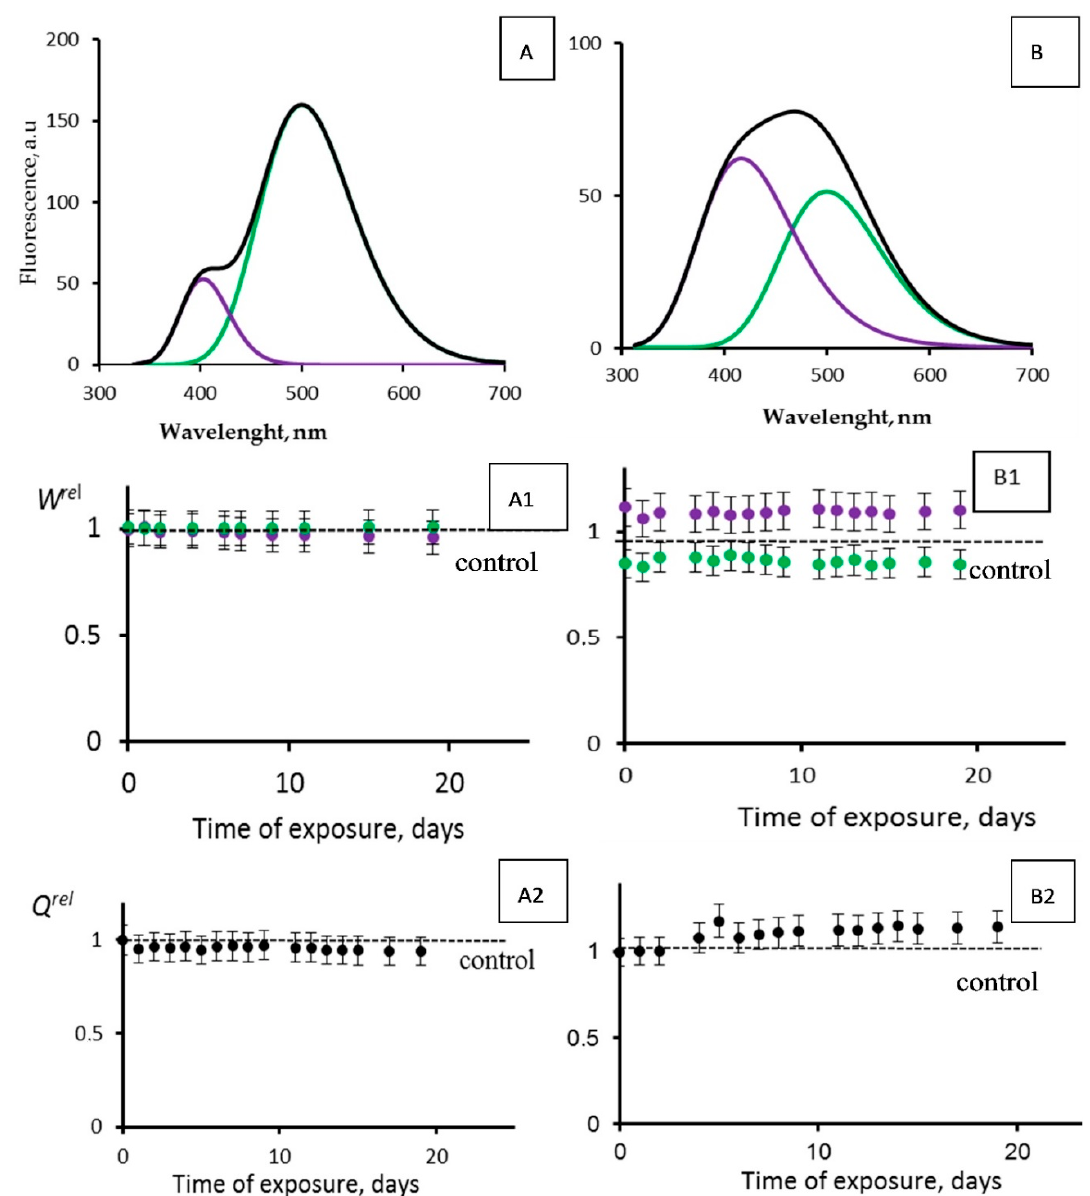
Figure 8. Photoluminescence spectra ( λ ext = 350 nm) of CLM-FP with ( A , B ) different contributions of violet and green components. Black line corresponds to overall spectra. ( A1 , B1 ) Violet (violet dots) and green (green dots) fluorescence contributions, W rel , and ( A2 , B2 ) fluorescence quantum yields, Q rel , vs. time of exposure to tritiated water, 200 MBq/L.